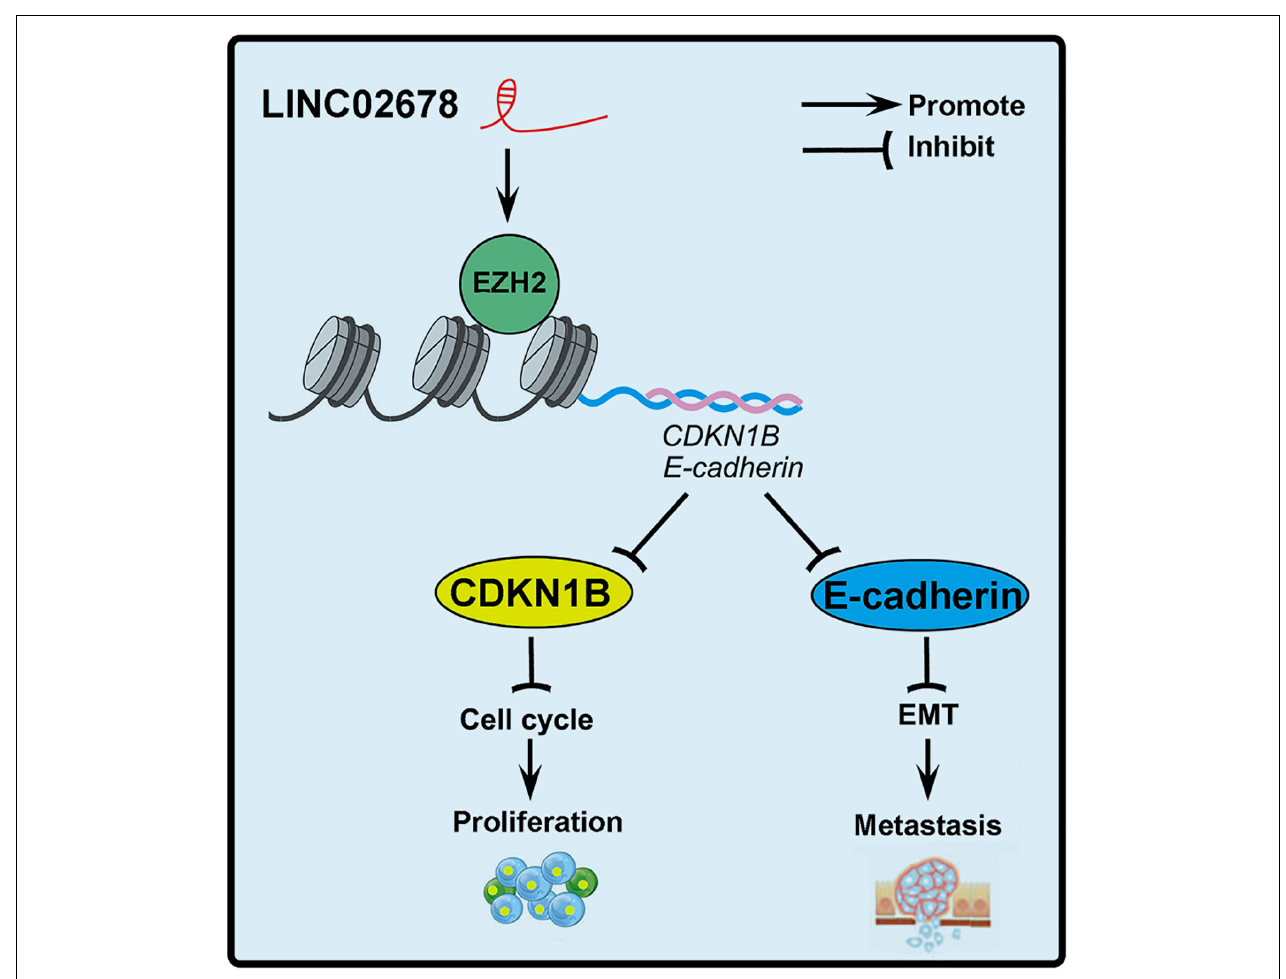
FIGURE 9 | The structural scheme and overall findings of this study. LINC02678 could interact with EZH2 to increase the expression level and activity of EZH2 mRNA and protein. Subsequently, activation of EZH2 epigenetically inhibited the expression of CDKN1B and E-cadherin in NSCLC cells, which promoted cell cycle progression and EMT, and ultimately the proliferation and metastasis of NSCLC